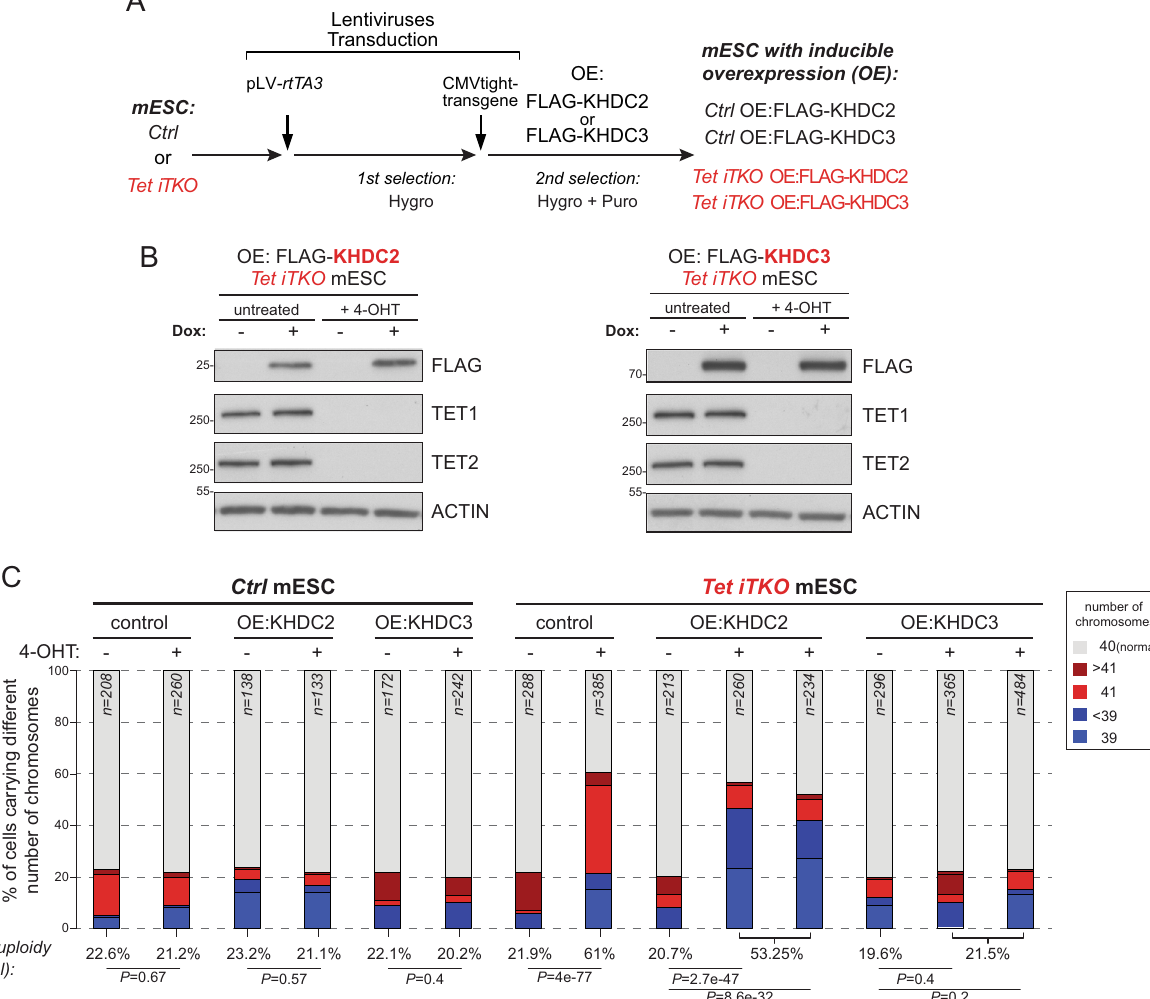
Fig. 5 | KHDC3 re-expression reverses the aneuploid phenotype of Tet iTKO mESC.A FlowchartoftheproceduretogeneratemESCwithdoxycycline-inducible overexpression (OE) of KHDC2 or KHDC3 in Ctrl ( Cre-ERT2 + ) and Tet T fl Cre-ERT2 + mESC. B Westernblotanalysisofdoxycycline-inducibleexpressionofKHDC2(left) or KHDC3 (right) in Tet iTKO mESC (untreated and treated with 4-OHT respec- tively). KHDC2/3 proteins were detected using anti FLAG-antibodies and the effective removal of TET proteins was con fi rmed as in Fig. 1C. ACTIN was used as loading control. OCT4 protein expression was unchanged in KHDC2- and KHDC3-